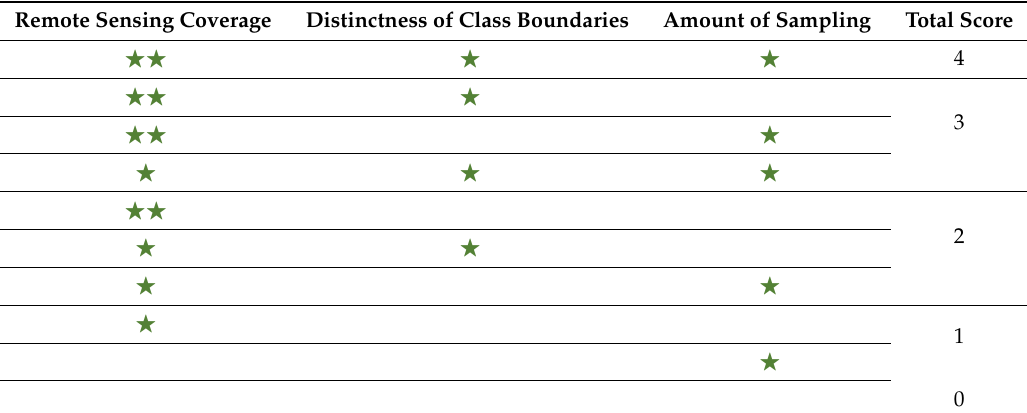
Figure 4. Confidence decision tree for EMODnet substrate mapping; the assessor starts at the top and follows the arrows. Table 3. Different combinations of scores that are possible under the three-step confidence assessment method for EMODnet substrate maps.